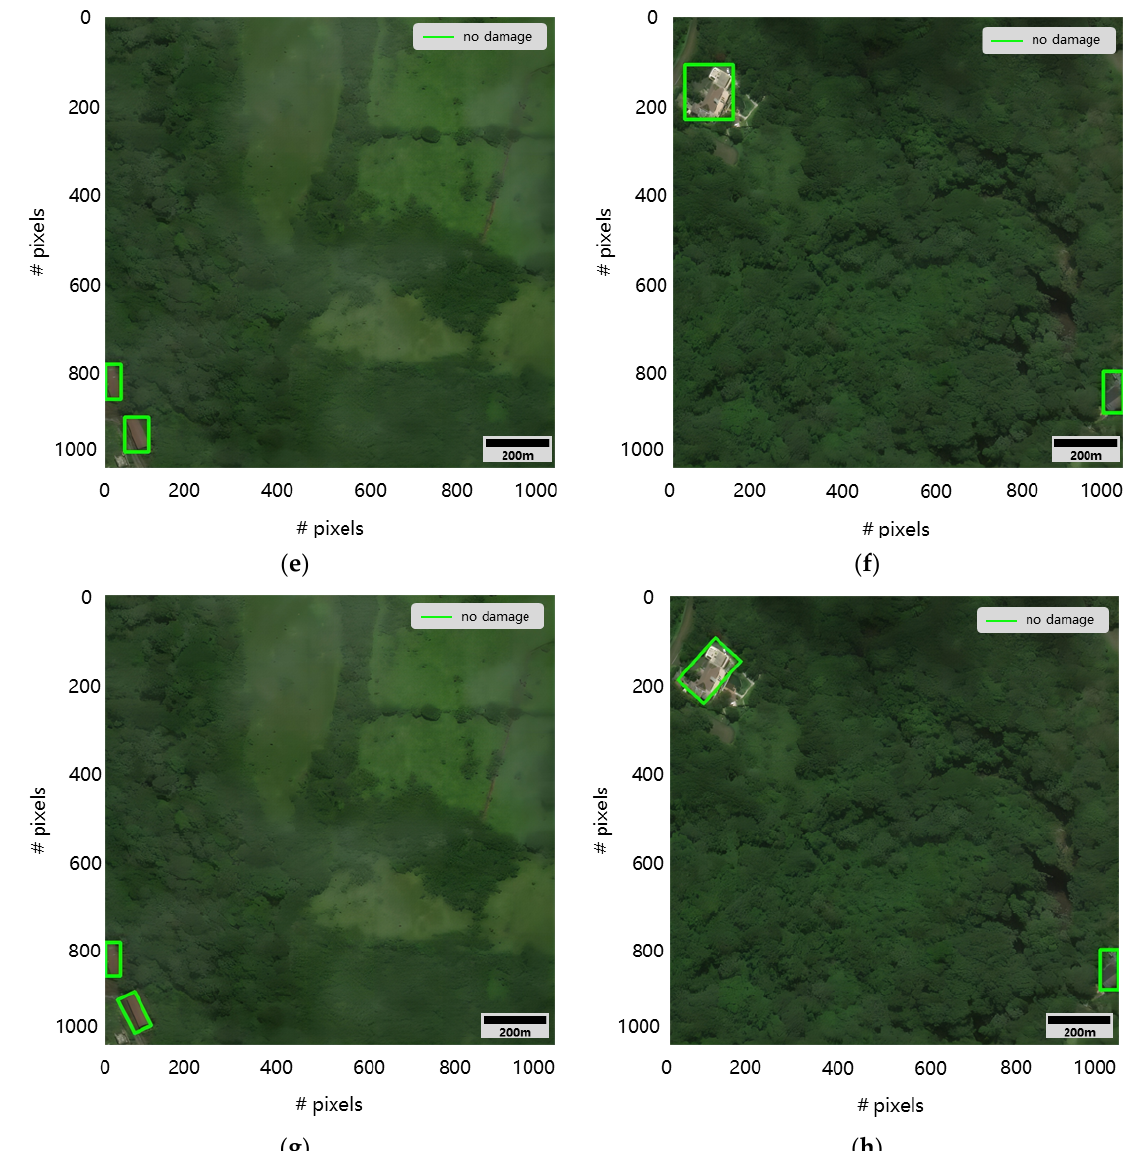
Figure 8. Randomly calculated test dataset of two images for YOLOX detection results and SegDe- tector horizontal and rotational detection results. ( a , b ) are Faster R-CNN detection results, ( c , d ) are YOLOX detection results, ( e , f ) are SegDetector-HBB detection results, and ( g , h ) are SegDetector-OBB detection results.